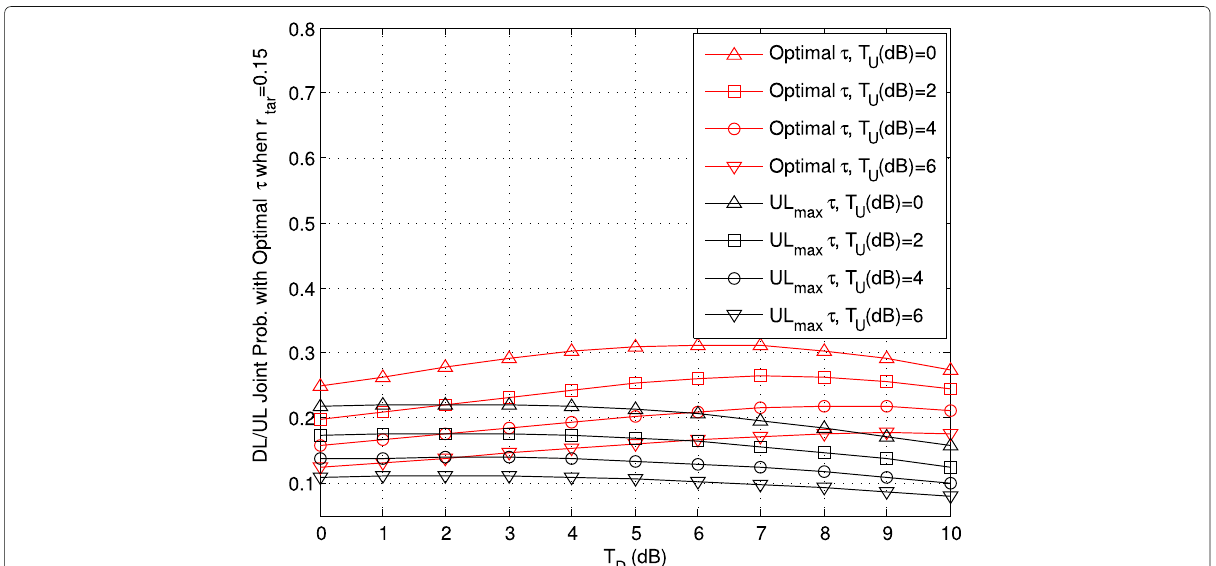
Fig. 7 DL/UL joint probability with the optimal τ for varying T d with different T u when r tar = 0.15